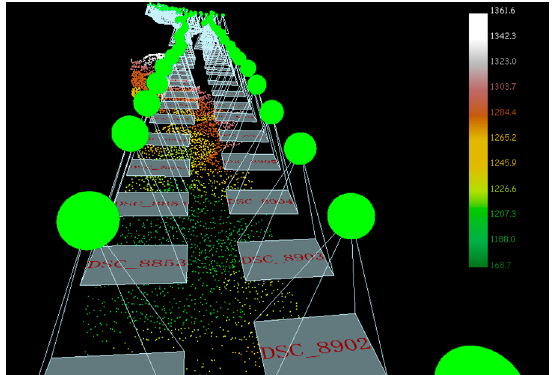
Figure 2. Schematic diagram of the strip arrangement. The green dots represent camera centers, and the gray rectangles below the green dots are the captured images in world coordinates. The small dots at the bottom are the projected ground points where the color represents different elevations indicated by the legend on the right in the figure.